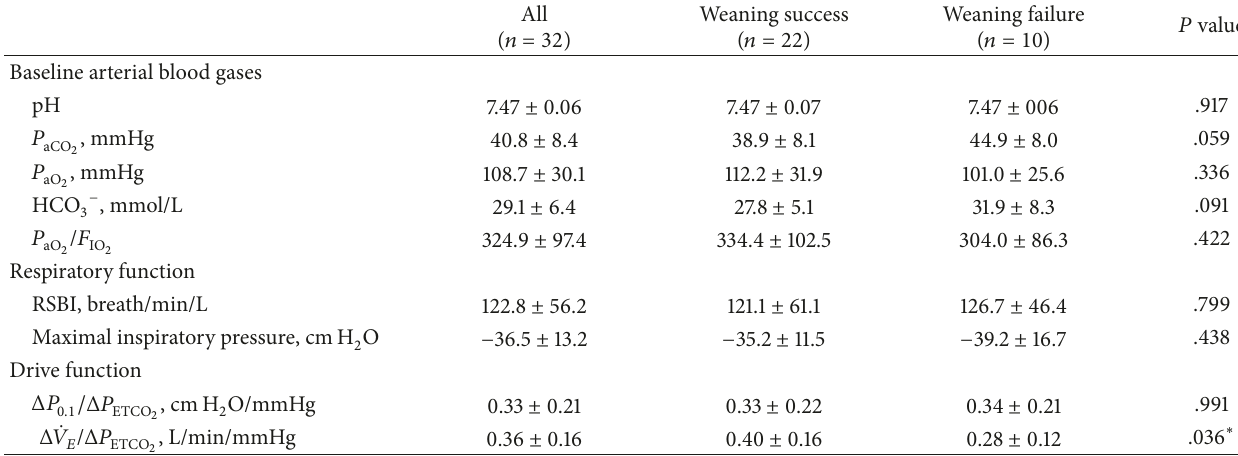
Table 2: Respiratory function assessment.